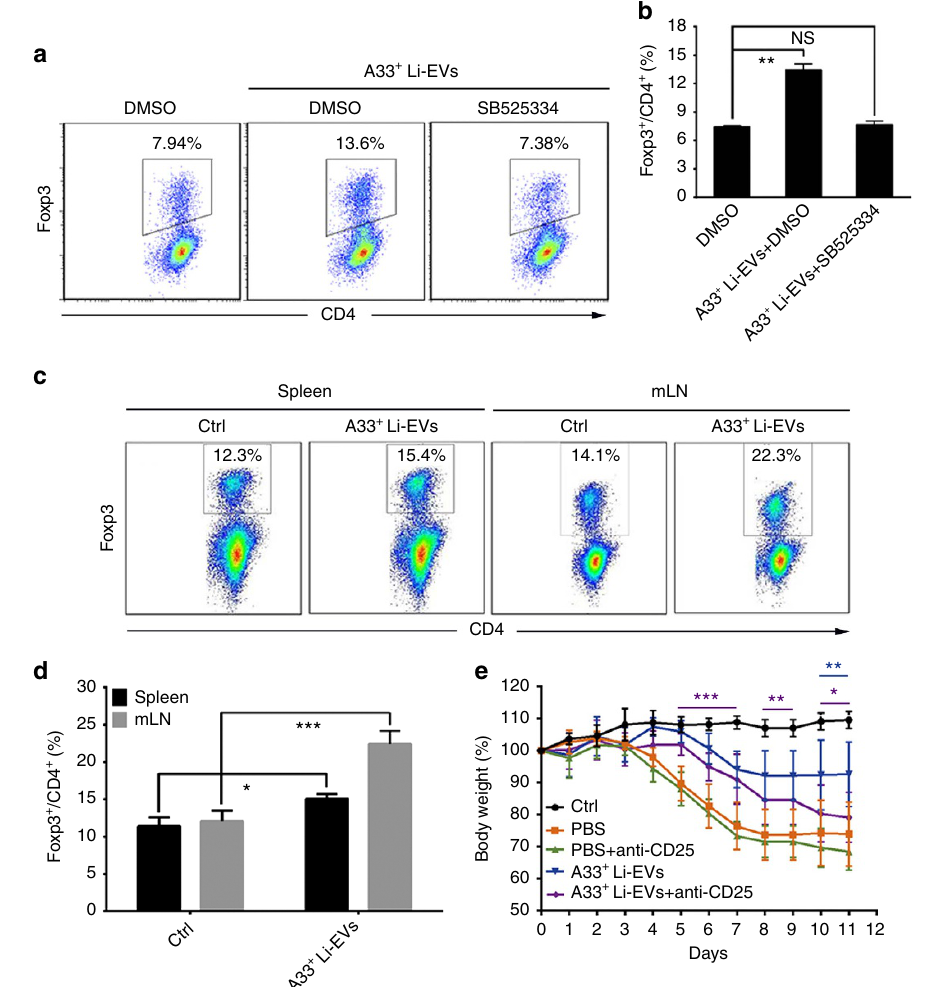
Figure 4 | Effects of A33 þ Li-EVs on Tregs and the severity of IBD. ( a ) In all, 1 (cid:3) 10 6 ml (cid:2) 1 naive CD4 þ Tcells were seeded into a 96-well plate and stimulated with 1 m l anti-CD3/CD28-coated beads. Then, 30 m gml (cid:2) 1 A33 þ Li-EVs with or without 0.5 m gml (cid:2) 1 SB525334 was added. After culture for 3 days, the differentiation of CD4 þ Foxp3 þ Tregs was analysed using FACS. ( b ) The data in a were statistically analysed ( n ¼ 9). ( c ) Mice received one intravenous injection